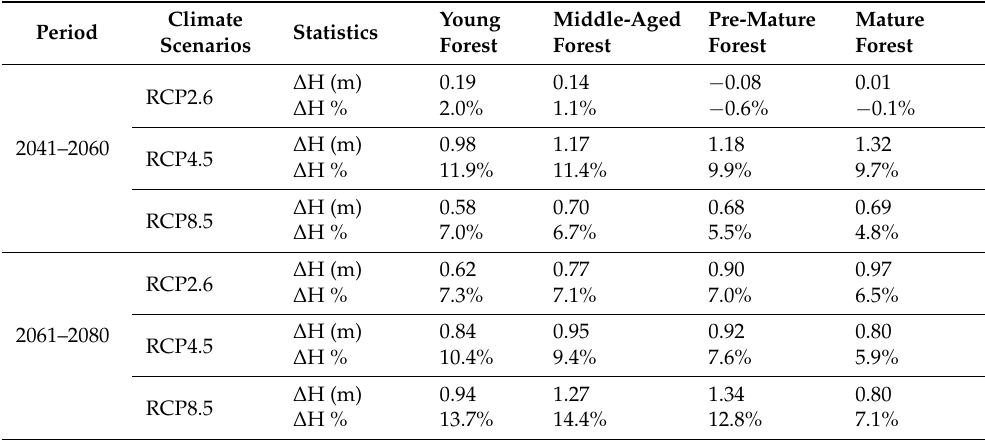
Table 4. Predicted dominant height difference under future climate scenarios at different stages and under different climate